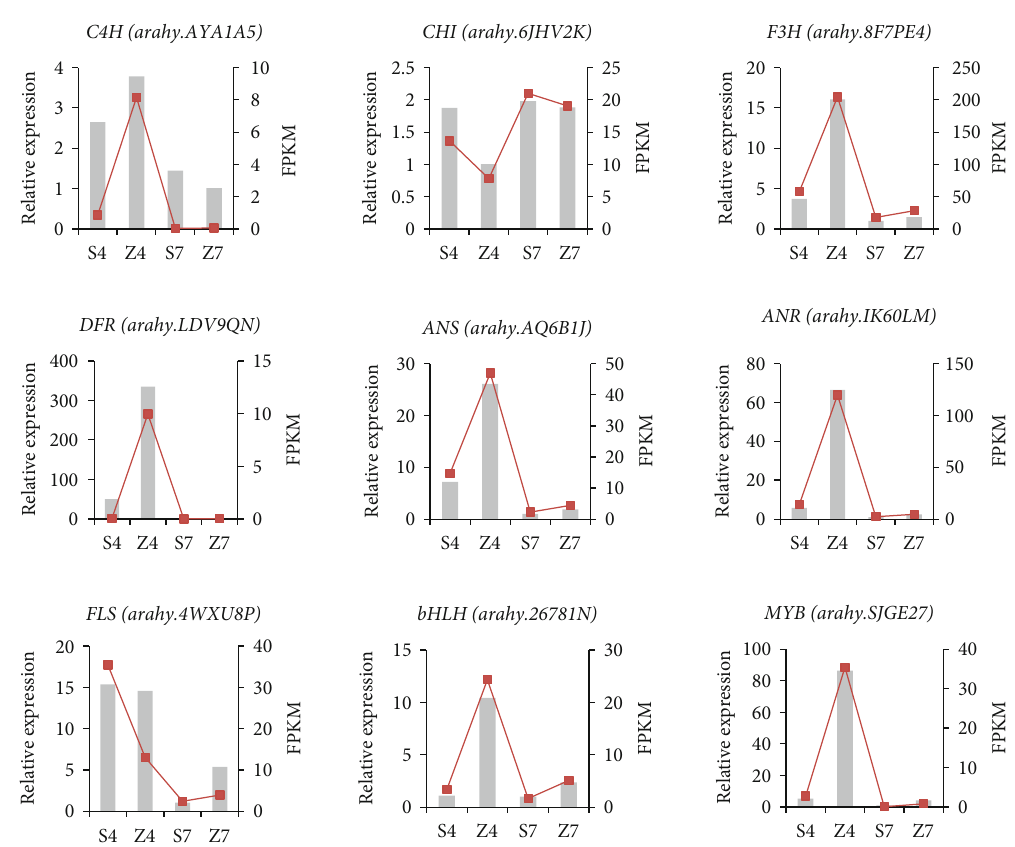
Figure 6: qRT-PCR veri fi cation of DEGs between S4, Z4, S7, and Z7. Transcript levels of 9 genes, which were involved in fl avonoid and anthocyanin biosynthesis. The y -axis shows the relative gene expression levels analyzed by qRT-PCR and RNA-Seq. The x -axis shows the testa sample of developmental stages. In this fi gure, gray columns correspond with expression data of qRT-PCR, while red lines denote data of RNA-Seq. S4, Shanhua15 R4 pod period; Z4, Zhonghua12 R4 pod period; S7, Shanhua15 R7 pod period; Z7, Zhonghua12 R7 pod